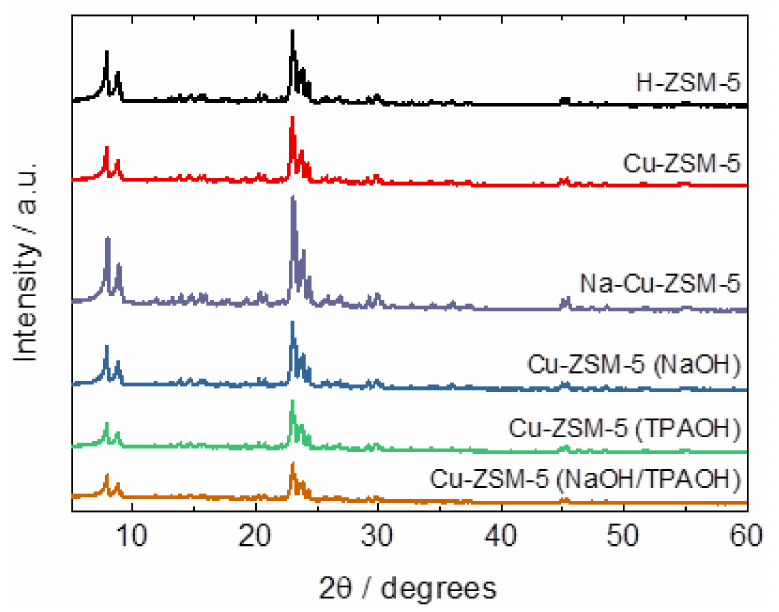
Figure 1. XRD patterns of H-ZSM-5, micro-/mesoporous Cu-exchanged ZSM-5 and Cu-exchanged ZSM-5 with co-cation (sample labels as in Table 1). Table 1. Chemical analysis results determined from ICP-OES measurements and changes in the samples crystallinity determined by